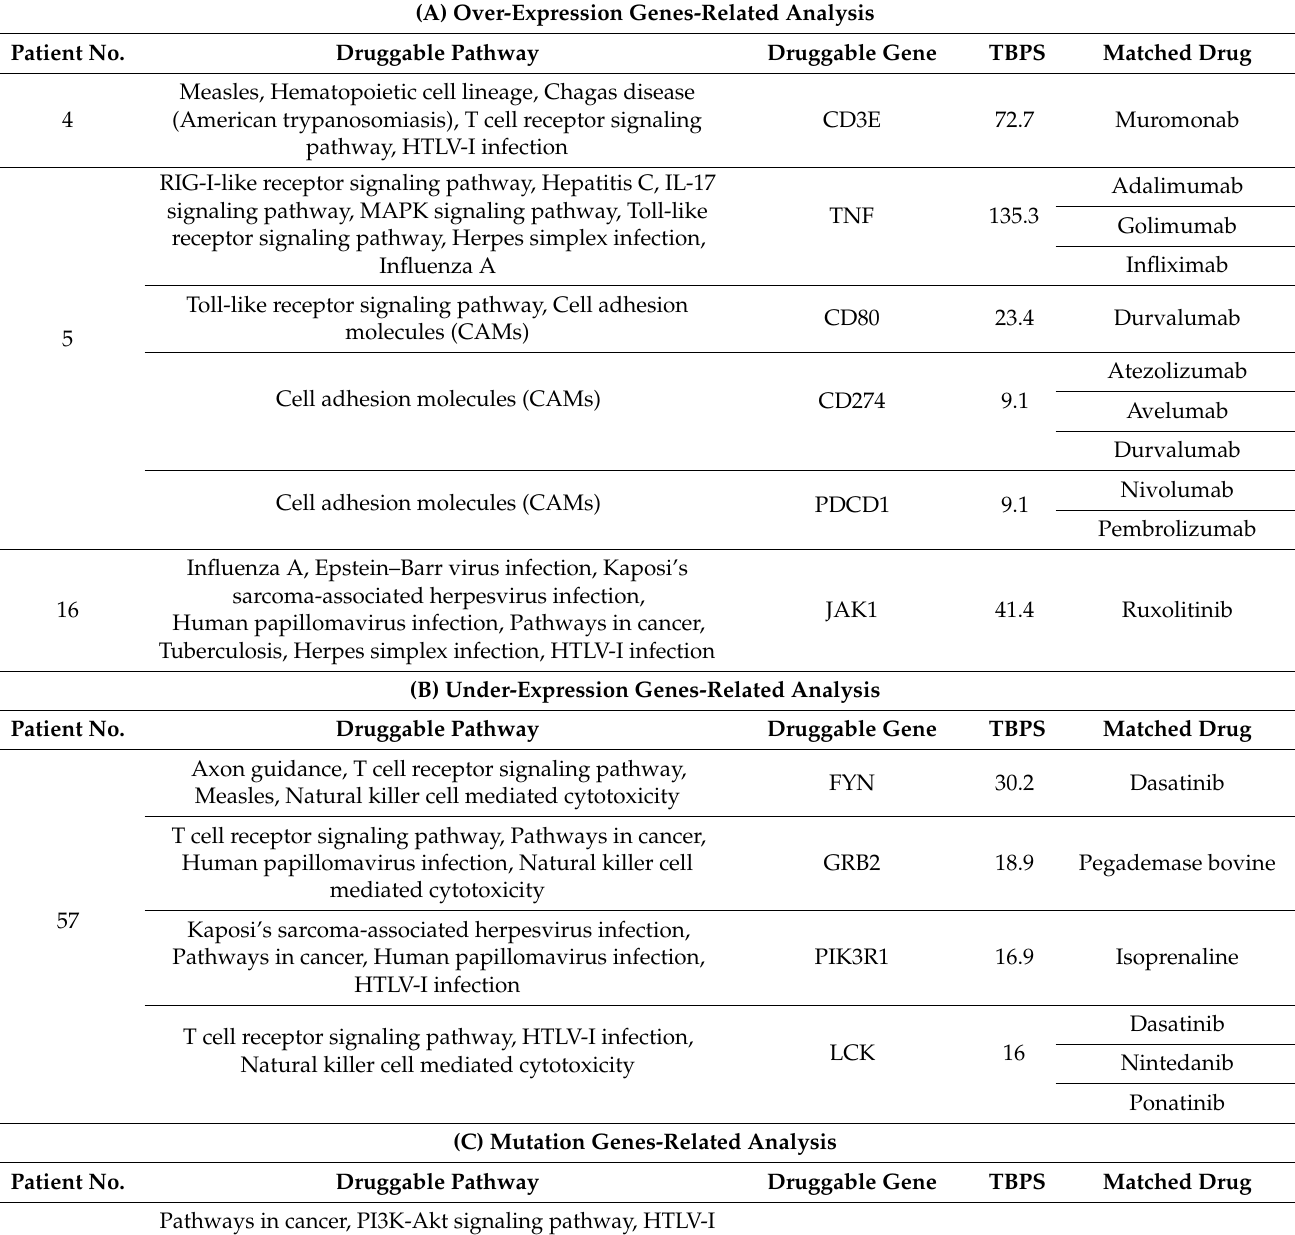
Table 4. Treatment Benefit Prediction Scores (TBPSs) and suggestion of specific drugs: (A) Over-expression genes-related analysis, (B) Under-expression genes-related analysis, (C) Mutation genes-related analysis. (A) Over-Expression Genes-Related Analysis Patient No.